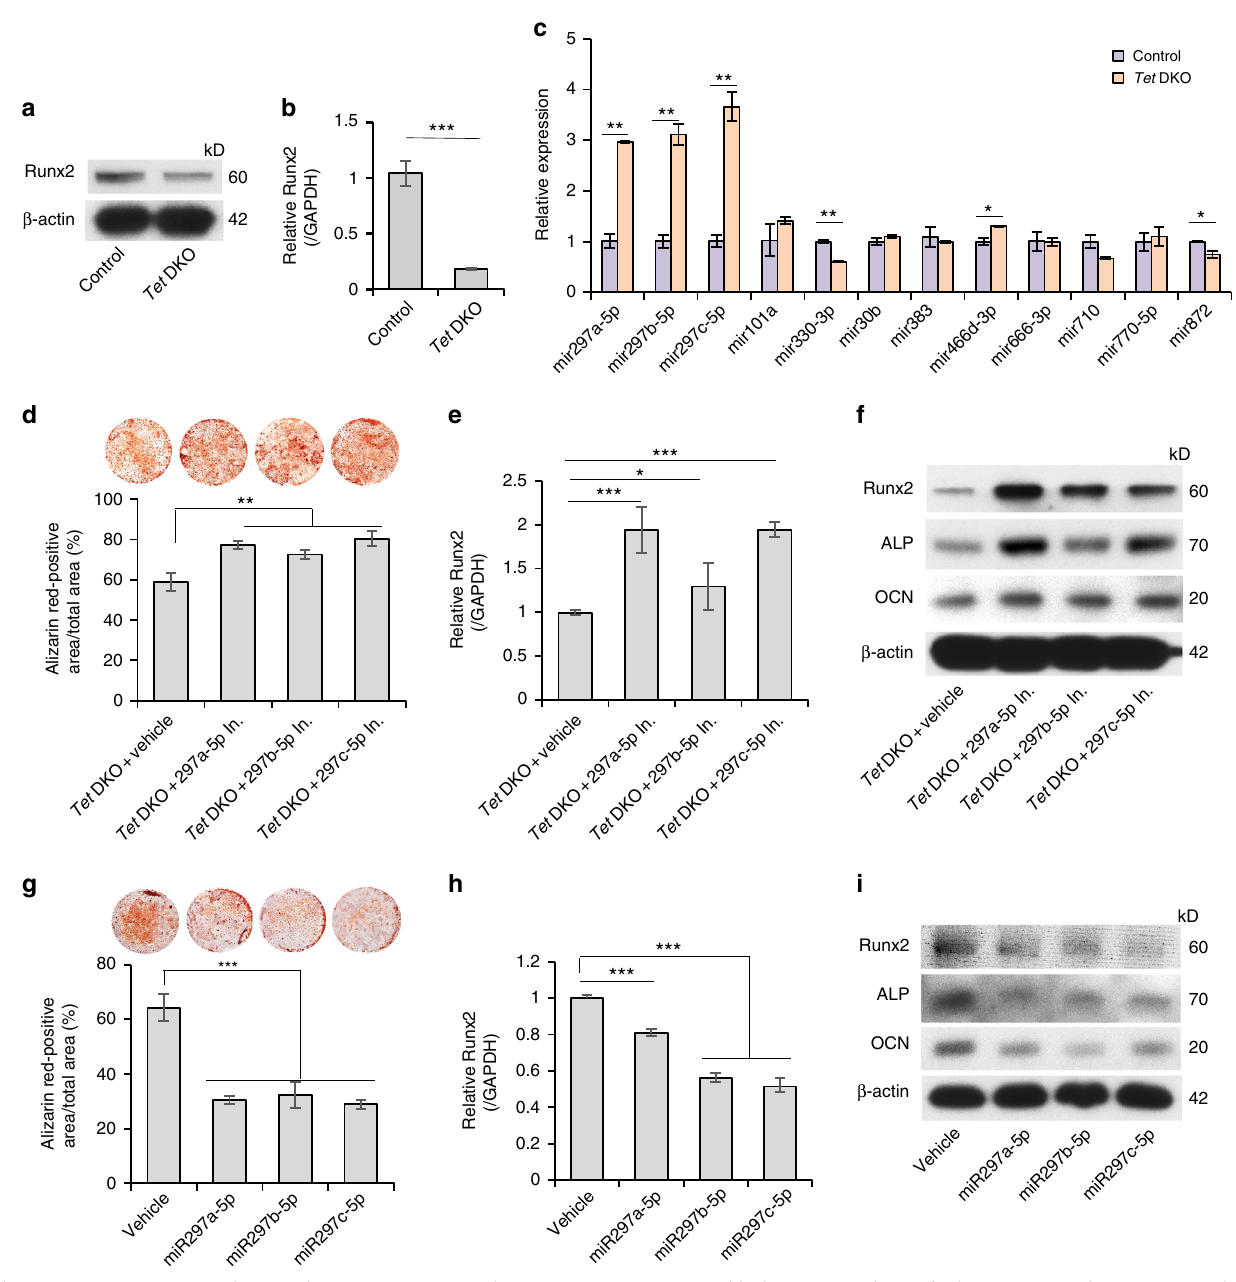
Fig. 4 miR-297a-5p, miR-297b-5p, and miR-297c-5p accumulate in Tet DKO BMMSCs to block Runx2 signaling. a , b The expression of Runx2 in control and Tet DKO BMMSCs was analyzed by western blotting and qPCR. c The levels of miR-297a-5p, miR-297b-5p, or miR-297c-5p in control and Tet DKO BMMSCs assessed by qPCR. d Mineralized nodule formation under osteogenic inductive conditions of Tet DKO BMMSC after miR-297a-5p, miR-297b-5p, or miR-297c-5p inhibitor treatment. e , f The expression levels of osteogenic markers Runx2 , ALP , and OCN in Tet DKO BMMSCs after miR-297a-5p, miR- 297b-5p, or miR-297c-5p inhibitor treatment, as assessed by qPCR ( e ) and western blotting ( f ). g – i Mineralized nodule formation and the expression of Runx2 , ALP , and OCN in BMMSCs after miR-297a-5p, miR-297b-5p, and miR-297c-5p mimic treatment as assessed by alizarin red staining ( g ), qPCR ( h ) and western blotting ( i ). * p < 0.05, ** p < 0.01, *** p < 0.001 (mean ± SD). Results are from three independent experiments. p values were calculated using two-tailed Student's t test ( b , c ) and one-way ANOVA ( d , e , g , h